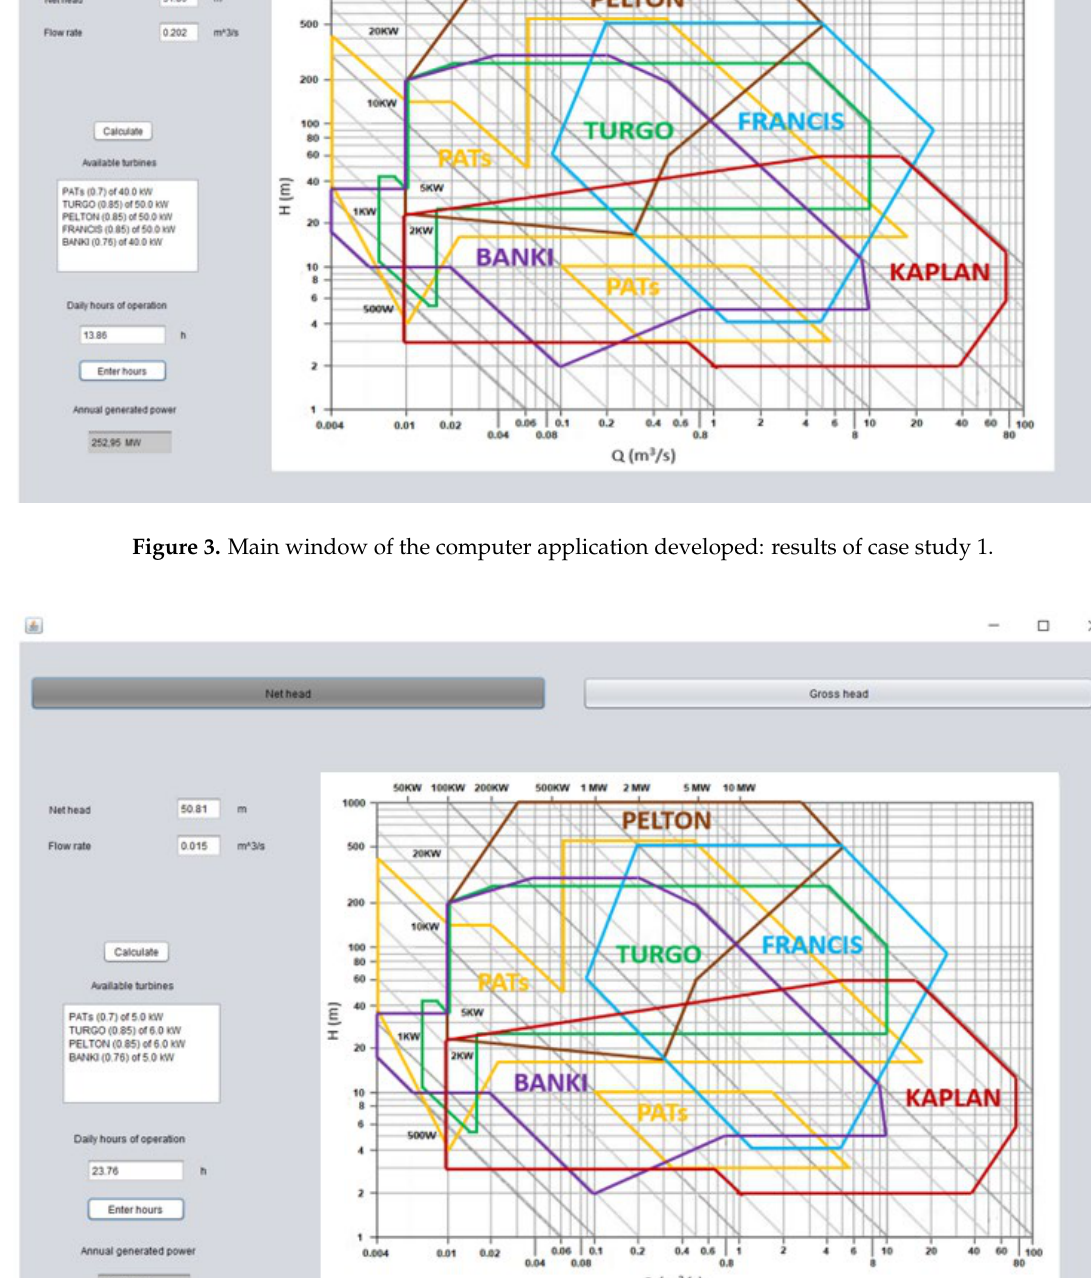
Figure 5. Main window of the computer application developed: results of case study 3.